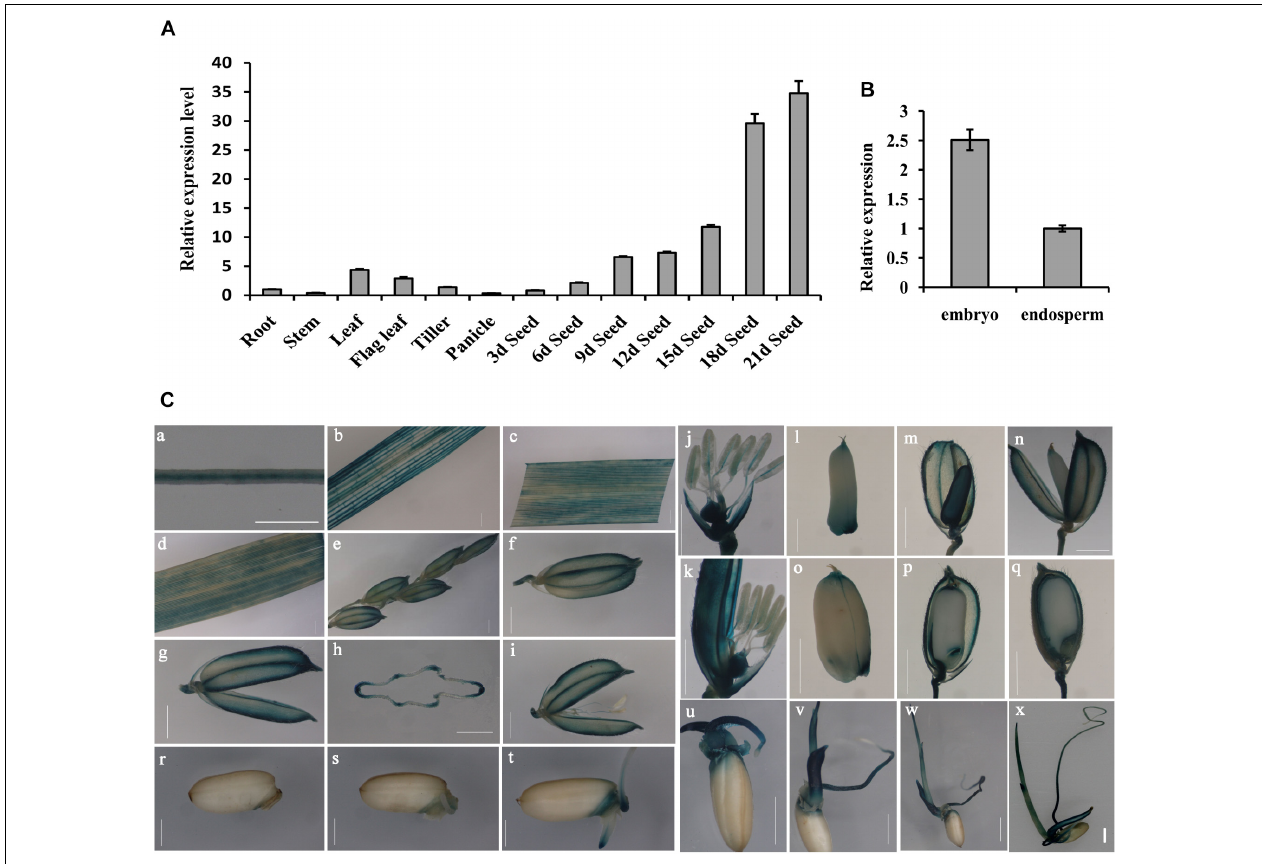
FIGURE 1 | Expression pattern analysis of OsGrxC2.2 . (A) Measurement of OsGrxC2.2 gene expression in various rice tissues. (B) Comparison of OsGrxC2.2 gene expression in the embryo and endosperm from dry seeds. The rice Actin1 gene ( OsActin1 ) was used as an internal control. (C) Histochemical analysis of GUS activity in pOsGrxC2.2 :GUS plants. Four-leaf-stage root (a) ; tillering stage stem (b) , leaf (c) ; heading stage flag leaf (d) , a hull before flowering (e–h) , flower (i–k) ; grain-filling stage developing seeds of 3–5 days (l–n) , 10–12 days (o, p), and 15–17 days (q) after flowering; and germinating seeds of 24 h (r) , 36 h (s) , 2 days (t) , 3 days (u) , 4 days (v) , 5 days (w) , and 6 days (x) ; (h) is the cross section of (g) . Bar = 0.5